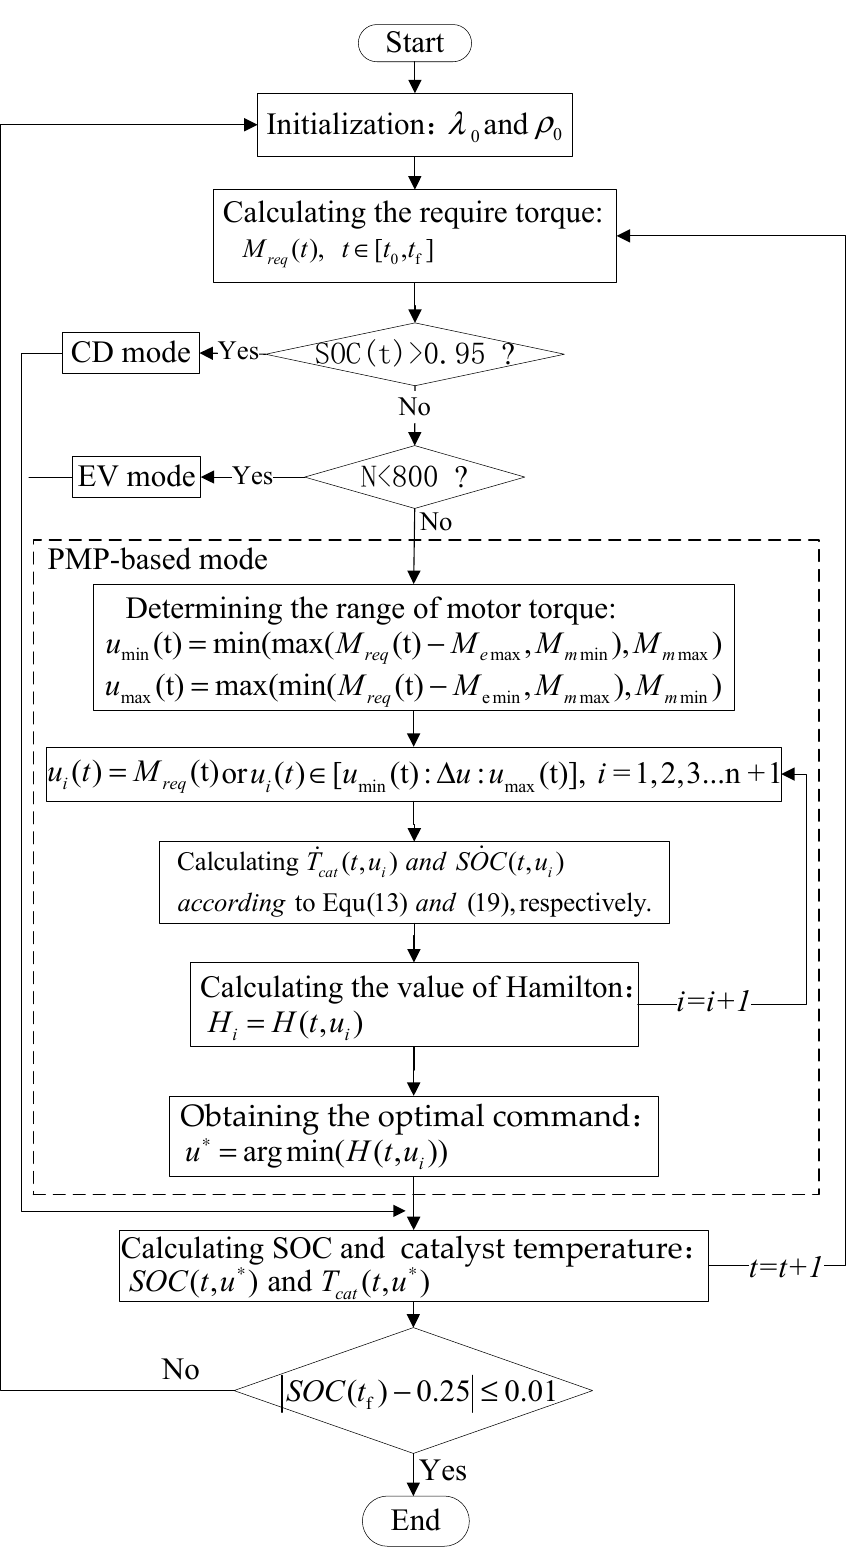
Figure 14. The calculation process of the integrated strategy.